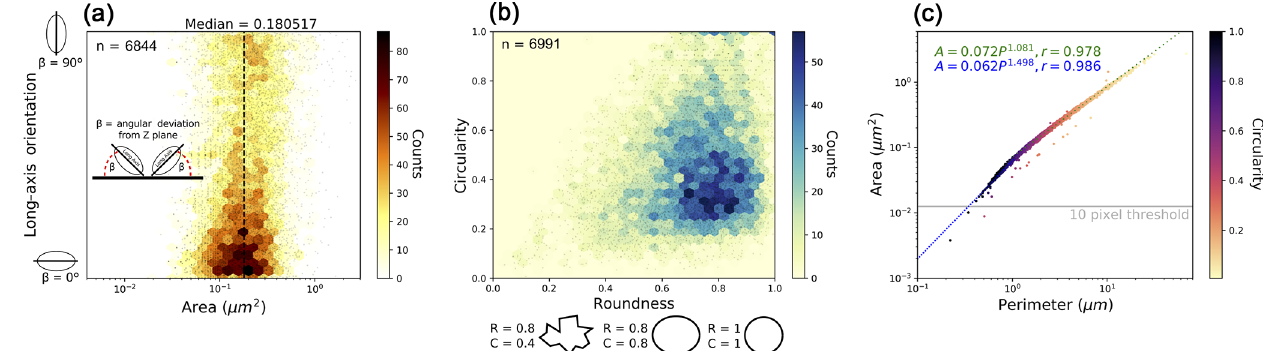
Figure 3. Plots of relationships for pore shape, size and orientation for all pores observed in association with the quartz domains of Fig. 1b. Due to the large sample size, pertinent clustering in data is more clearly observed when presented in hexbin plots (actual data points are overlain). In Fig. 3a and b, the hexbin plot colouring displays the number of data points contained within each hexbin. Panel (a) presents area as a function of pore long-axis orientation ( β = 0 ◦ is parallel to the Z plane of finite strain and β = 90 ◦ is parallel to the X plane of finite strain). Circular pores (circ = 1) are excluded from panel (a) because the long of a circle will not have a unique or meaningful orientation. Panel (b) compares each pore’s circularity with its roundness. One large cluster (circ = 0.3, round = 0.8) and two minor clusters (circ = 1, round = 1; circ = 1, round = 0.8) are observed. Panel (c) shows the relationship of pore perimeter with increasing cross-sectional area. Each data point is additionally coloured for its circularity. Two power-law trends are identified in panel (c) . See text for further discussion. Table 1. Porosity data from Fig. 2. Domain Number of pores % of total Absolute porosity Porosity presented in domain porosity (%) (µm 2 ) as % of total area of Fig. 1b (%) Quartz 6991 86 1515 0.07 Porphyroclast + polyphase 1138 14 247